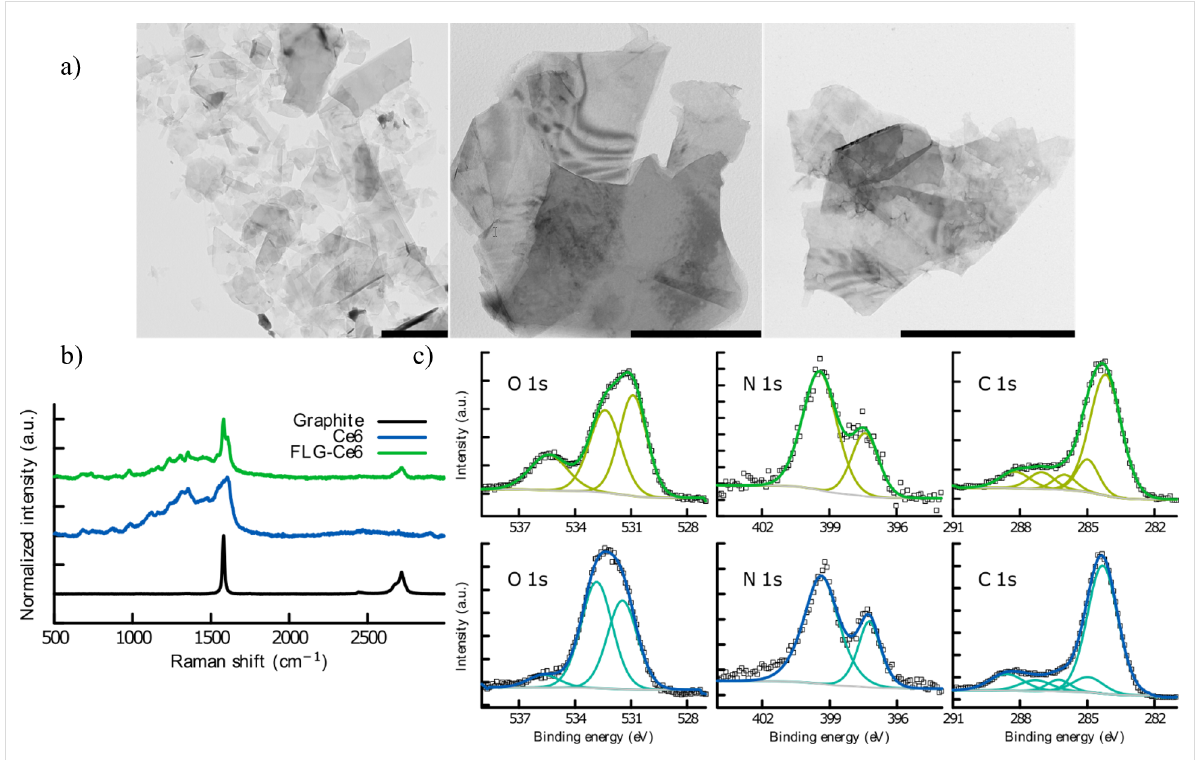
Figure 1: Characterization of the FLG-Ce6 hybrid nanomaterial. a) TEM images of FLG-Ce6; scale bar is 1 µm. b) Raman spectrum of FLG-Ce6, Ce6 and graphite. c) XPS spectra. Top row (green) shows the FLG-Ce6 chemical analysis and bottom row (blue) shows the respective analysis for